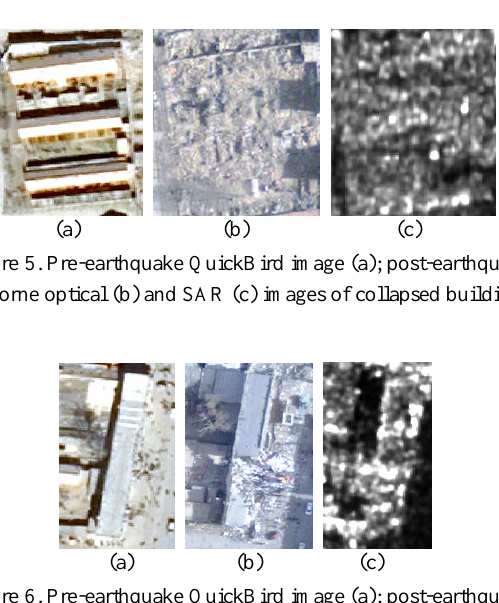
Figure 4. Post-earthquake airborne optical image (a) and SAR image (b) of un-collapsed building.